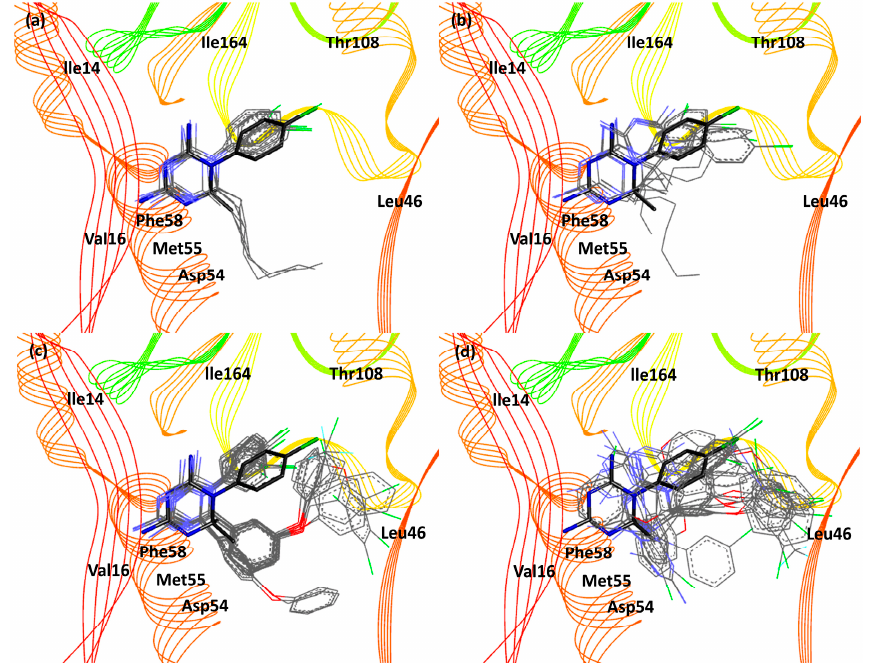
Figure 6. Superposition image of Cyc derivatives ( p- and m- chlorophenyl substituent) with the reference structure in the mutant pf DHFR binding pocket. Cyc24–31 and Cyc42 (R 2 is alkyl chain) in ( a ) R configuration and ( b ) S configuration. Cyc32–41 and Cyc43–46 (R 2 is phenol chain) in ( c ) R configuration and ( d ) S configuration. Cycloguanil derivatives and the reference structure are shown as line model and stick model, respectively. Black, blue, and green indicates carbon, nitrogen, and chlorine atom, respectively.